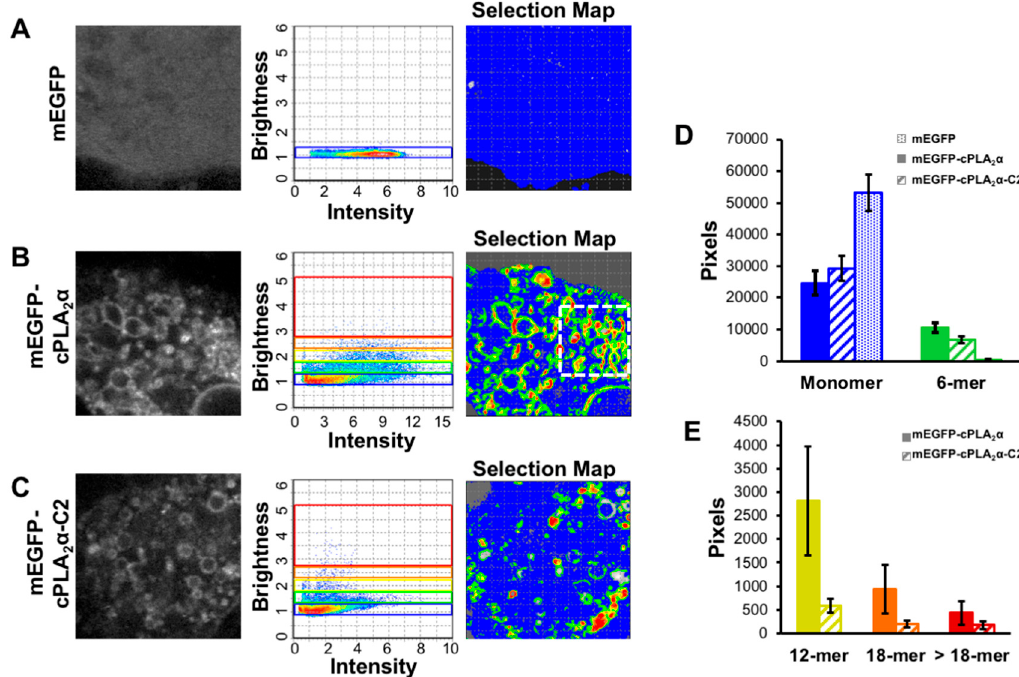
Figure 2. cPLA 2 α oligomerizes on cellular membranes in A549 cells. A549 cells were transfected at 70–90% confluency with mEGFP, mEGFP-cPLA 2 α or mEGFP-cPLA 2 α -C2 for 24 h. All cells were treated with 10 µ M A23187 for 30 min then imaged with confocal microscopy. ( A – C ) (from left to right) A representative image of Raster Image Correlation Spectroscopy (RICS) data displaying the cytoplasmic localization of fluorescent constructs in A549 cells. Each intensity and brightness plot shows protein oligomerization where increased brightness corresponds to larger protein structures. The selection map displays the selected pixels from the brightness plot mapped back to the cellular morphology. ( D , E ) Results were quantified through the analysis of 11 separate cellular data sets from 2 independent experiments using the simFCS software. Graphs display the number of pixels on the y -axis and the size of EGFP-tagged protein on the y -axis (monomer, 6-mer, 12-mer, 18-mer, and >18-mer). Results are plotted for EGFP (dot filled), EGFP-cPLA 2 α (solid filled), and EGFP-cPLA 2 α -C2 (hash filled).